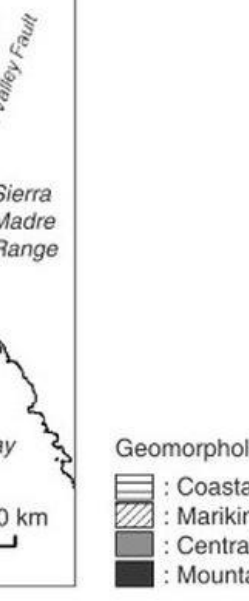
Figure 3. Geology map of study area within Metro Manila.